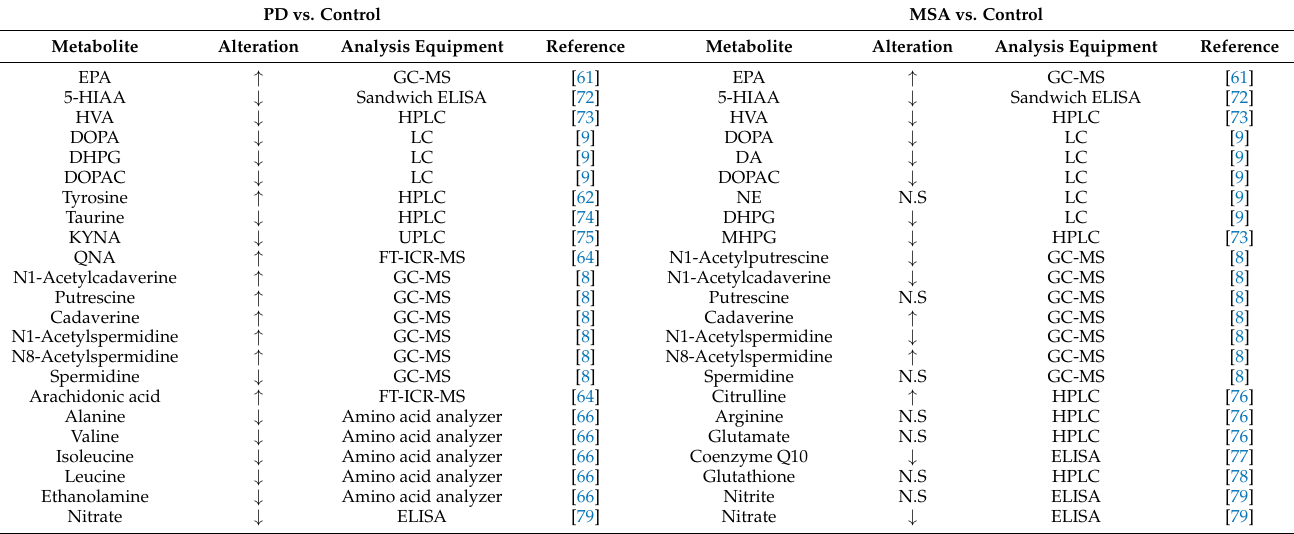
Figure 1. Functional analysis of the metabolomic network of cerebrospinal fluid from Parkinson’s disease patients using the ingenuity pathway analysis (IPA) program. Non-predicted metabolomic network ( A ) and predicted metabolomic network ( B ). Red and green areas indicate upregulated and downregulated metabolites, respectively. Orange and blue areas indicate activation and suppression by IPA prediction, respectively. Prediction legends are provided from IPA (http://www.ingenuity. com, accessed on 16 January 2022). Table 1. Altered metabolites in PD and MSA